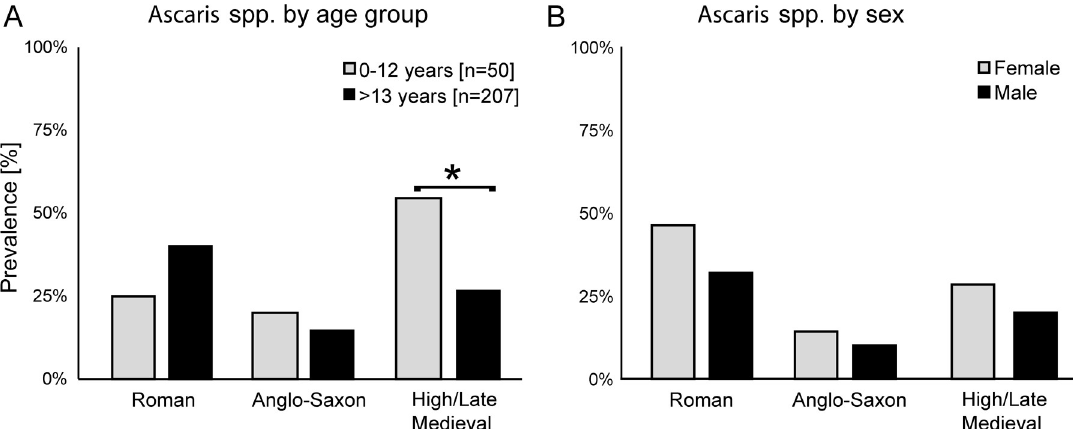
Fig 4. Age and Sex-associated effects on prevalence rates for Ascaris . Samples with associated osteological age were grouped into juveniles (0–12 years old, n = 50) and adults ( > 13 years old, n = 207) and according to period (A). The prevalence in juveniles was significantly higher in the High/Late Medieval period (Fisher Exact two-tailed p-value 0.02). Individuals where osteological sex was identified (adult individuals only, n = 194 with n female = 85 and n male = 109) were grouped by period (B). No significant differences were